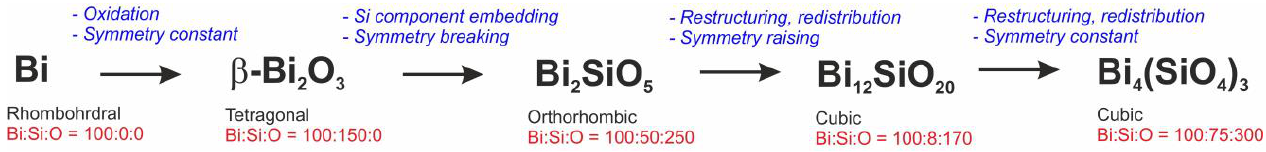
Figure 8. Scheme of phase transformation during thermal treatment of samples.